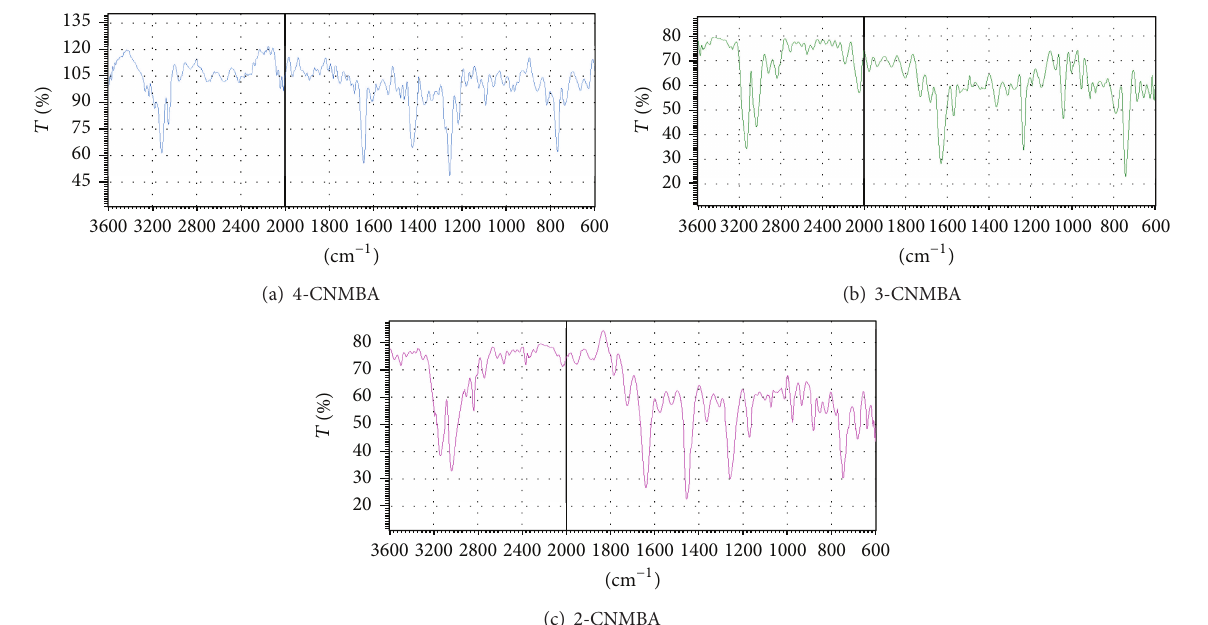
Figure 2: IR spectra of studied Schiff bases (a) 4-CNMBA, (b) 3-CNMBA, and (c)